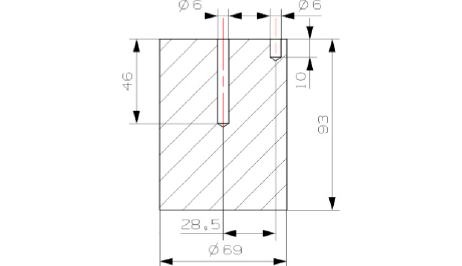
Figure 2. Billet dimensions (mm) and thermocouple location to record the temperature during the heating cycles.